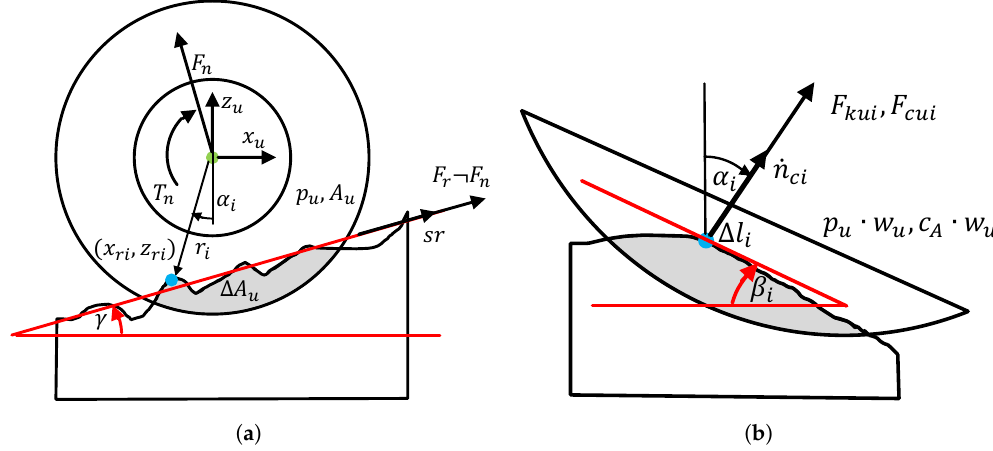
Figure 3. Tire model for uneven road: ( a ) tire subjected to road irregularities and ground normal forces, ( b ) tire stiffness and damping